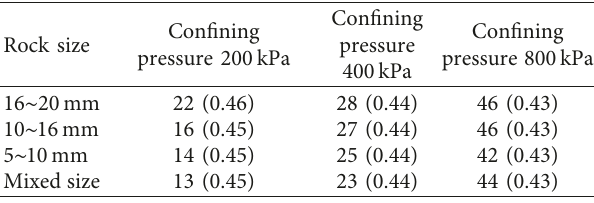
Table 7: Elastic modulus and Poisson’s ratio (in brackets) of different confining pressures and rock sizes.